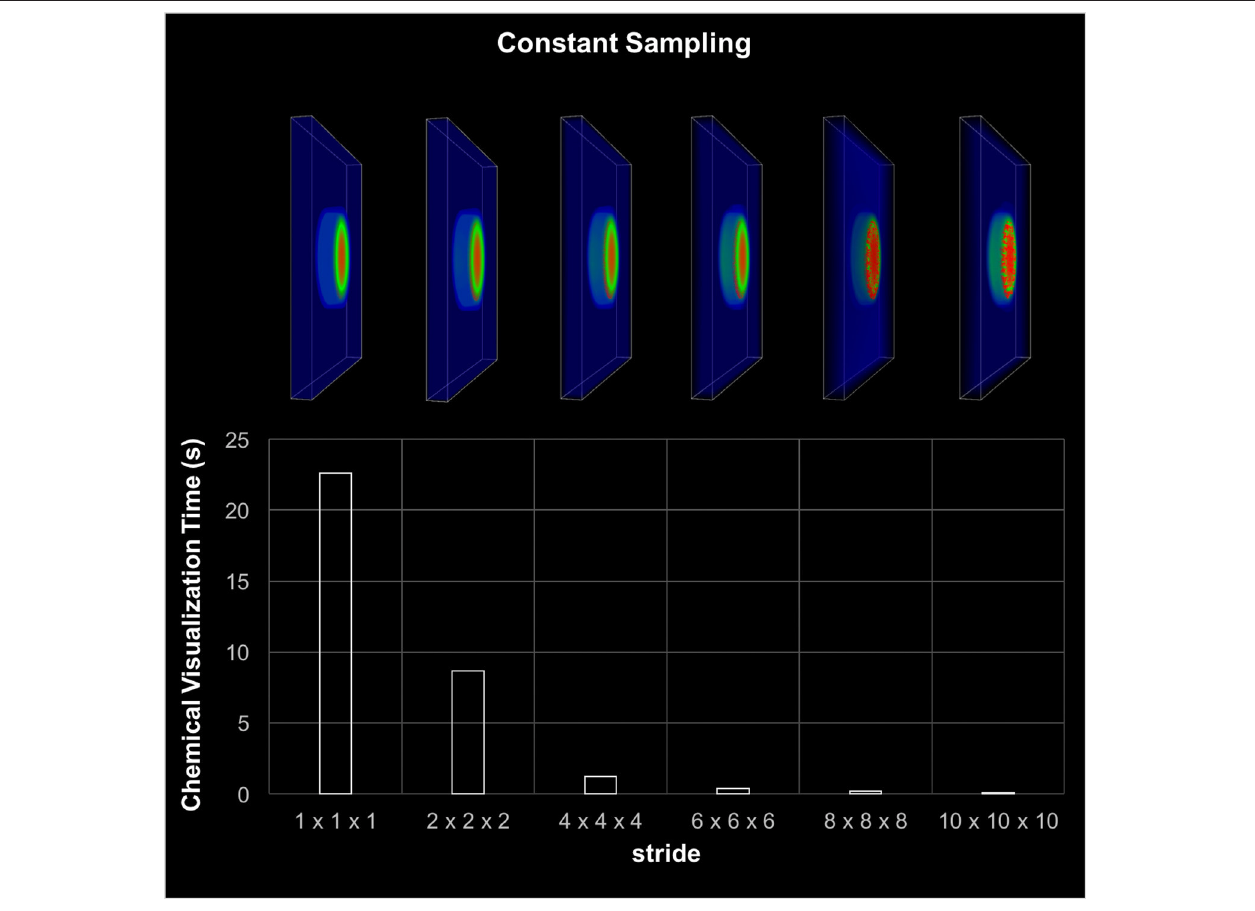
FIGURE 6 | Visualization-only performance. This chart shows visualization screenshots and corresponding execution time for different sampling resolutions. The stride denotes the gap between two consecutive sampled points, thus the higher the stride the coarser the sampling. The visual appearance of the each sampling case looks almost identical for up to stride 6 or 6 3 sampling windows. The visualization was able to retain sufficient information by using 6 3 sampling.